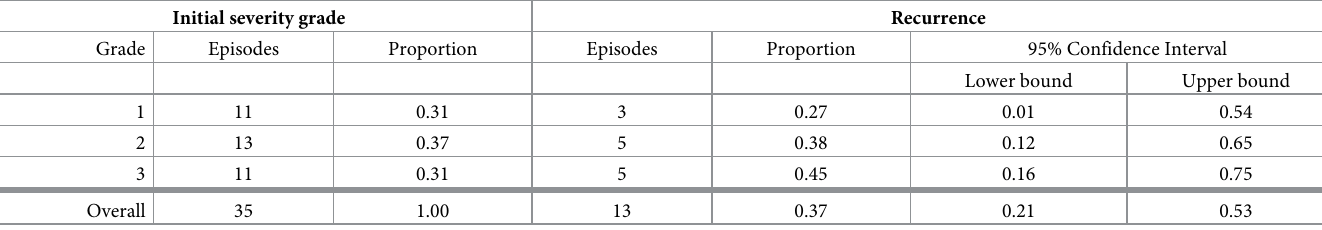
Table 6. Probability of recurrence within a 12-month period by initial severity